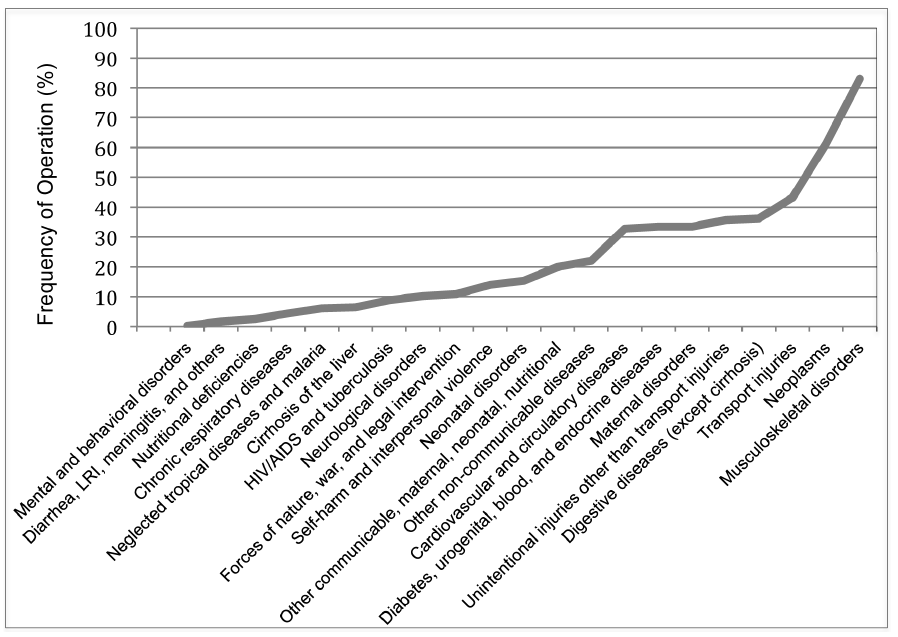
Figure 2. Continuum of operation frequency by disease subcategory. doi:10.1371/journal.pone.0089693.g002 PLOS ONE |